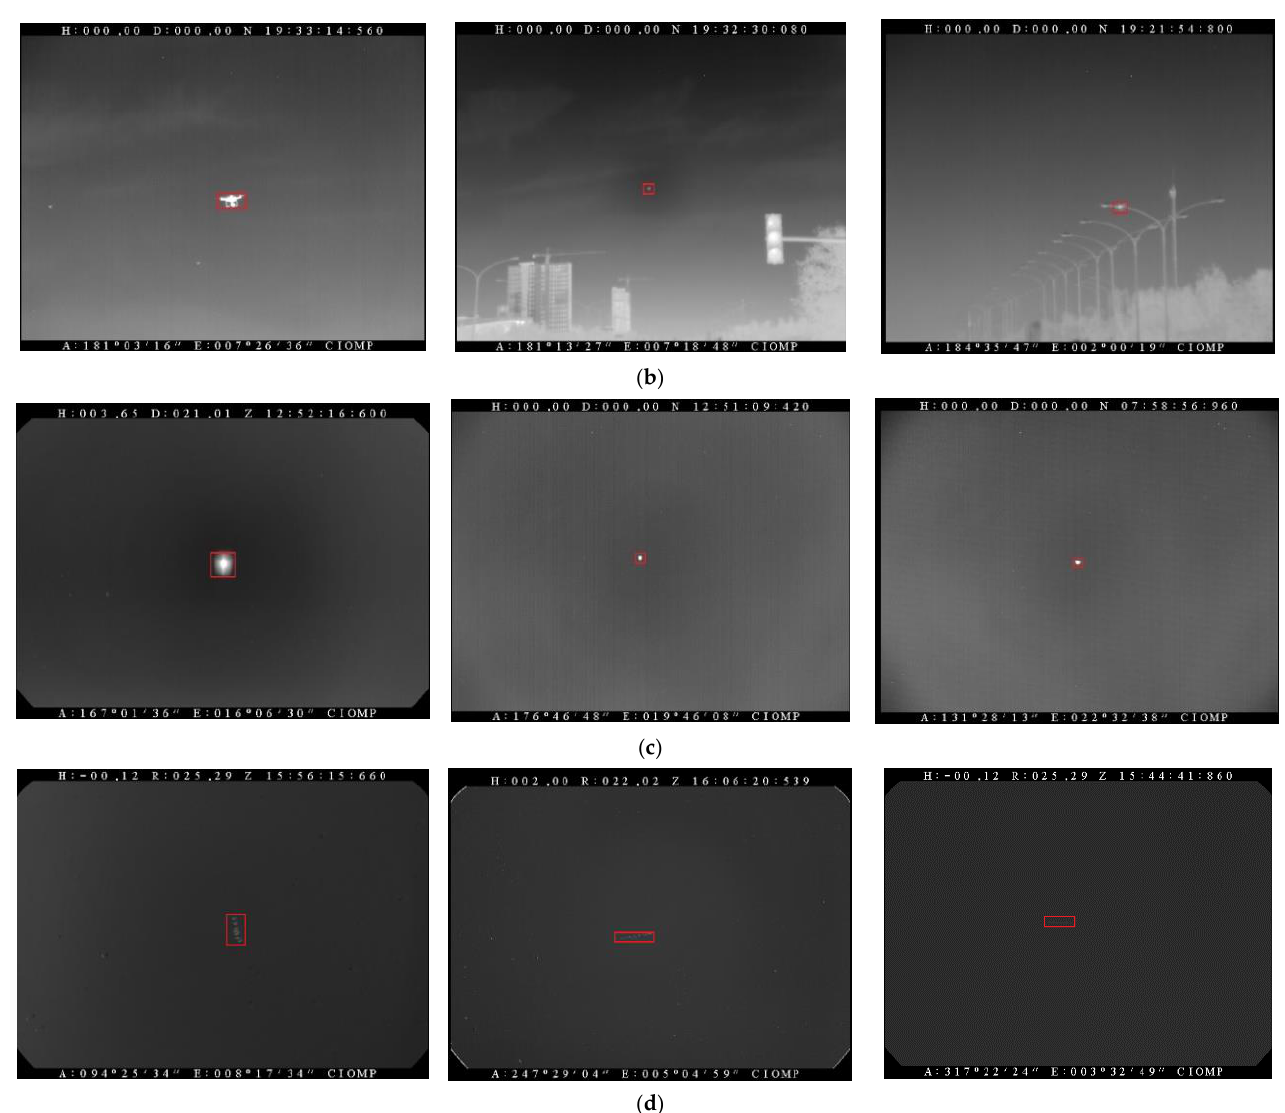
Figure 2. Some infrared images in our infrared small-target OEDD. ( a ) Large and medium aircraft; ( b ) small aircraft; ( c ) floating ball; ( d ) birds. ( b ) small aircraft; ( c ) floating ball; ( d )